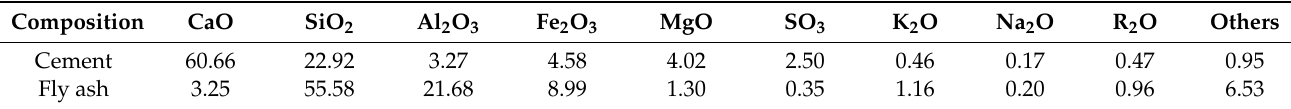
Table 2. Chemical composition of cementitious material (% by